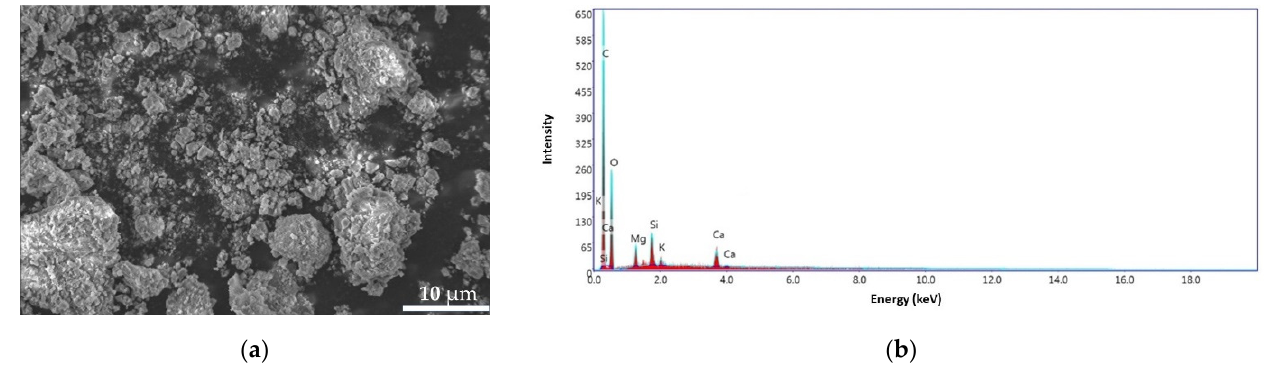
Figure 13. SEM images for ALG–BPA (1:1) microbeads at 8000× ( a ) and the EDS pattern ( b ).